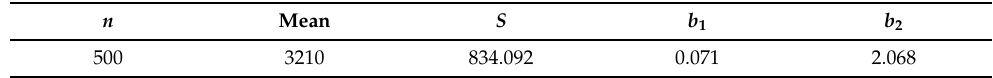
Table 5. Summary statistics for the variable birthweight.